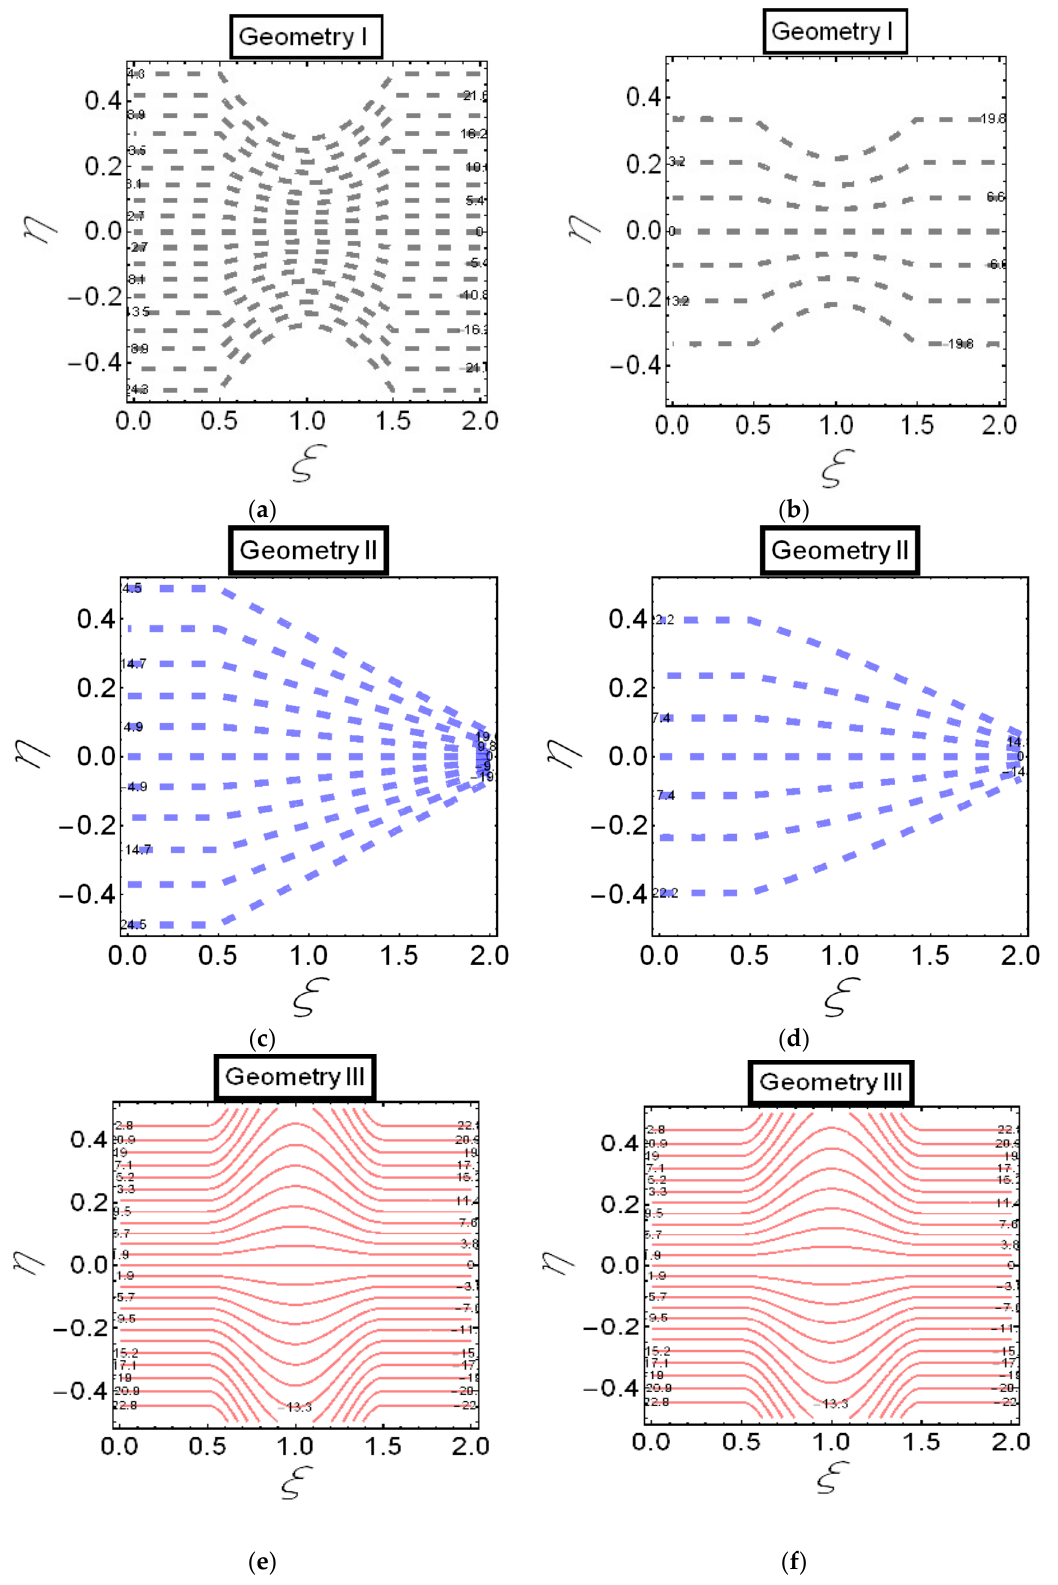
Figure 13. Streamlines for m = 2 ( a , c , e ) and m = 5 ( b , d , f ).